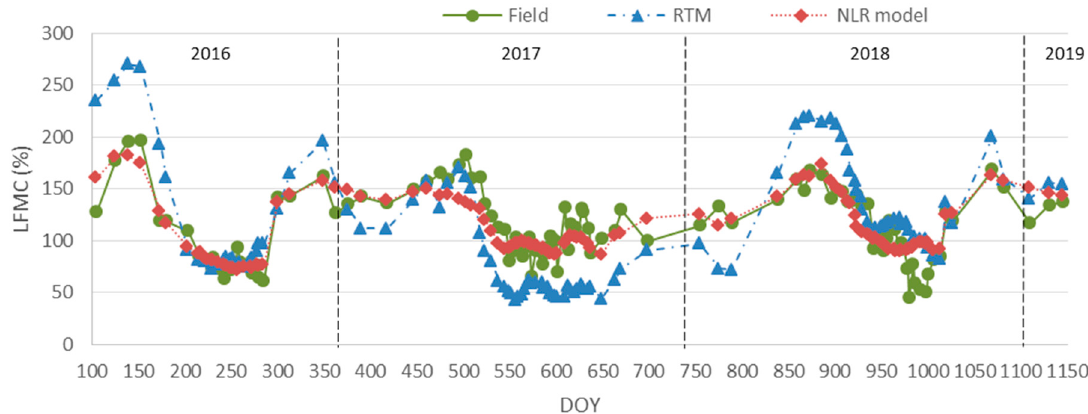
Figure 6. Comparison of C. ladanifer LFMC values from field monitoring and estimations from RTM and an empirical model (NLR).